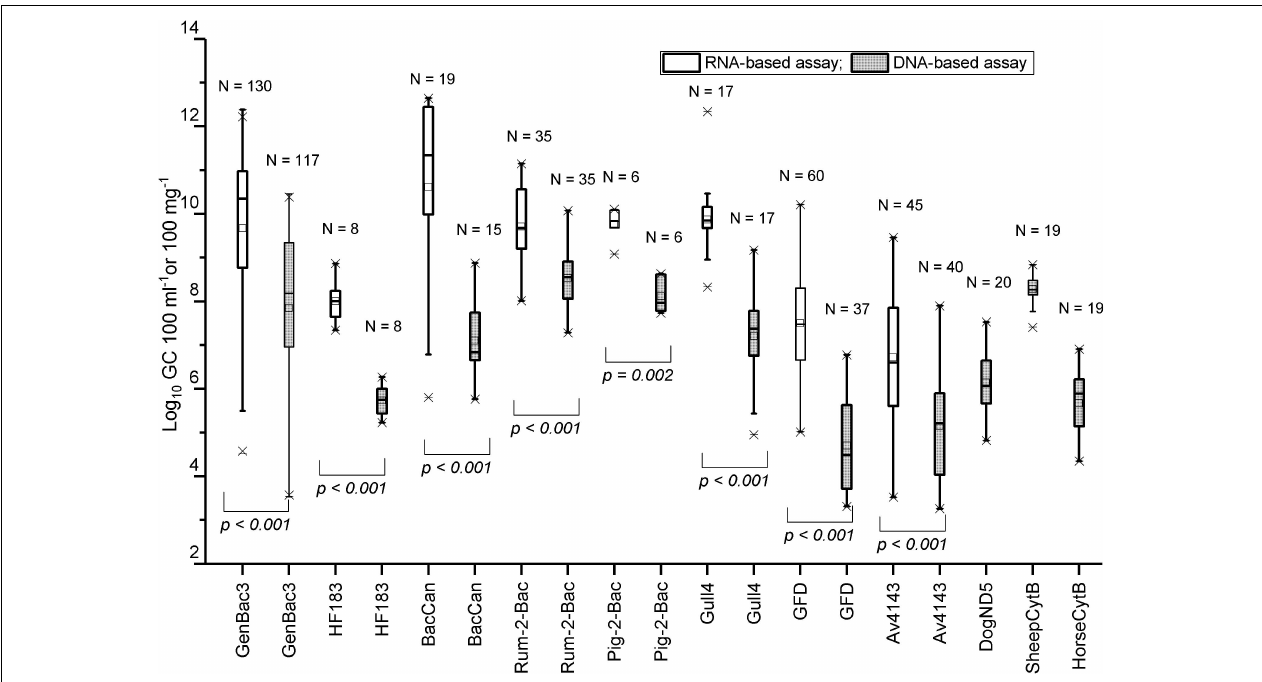
FIGURE 2 | The comparison between RNA-based and DNA-based copy numbers. The fecal and sewage samples were analyzed using the respective host-specific MST marker assays. The p -Value is based on the Mann–Whitney U -test. N: the number of samples included in the comparison ( >